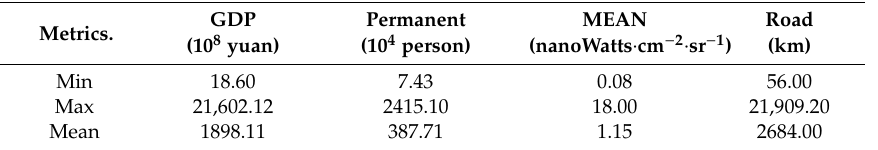
Table 1. 2013 summary.